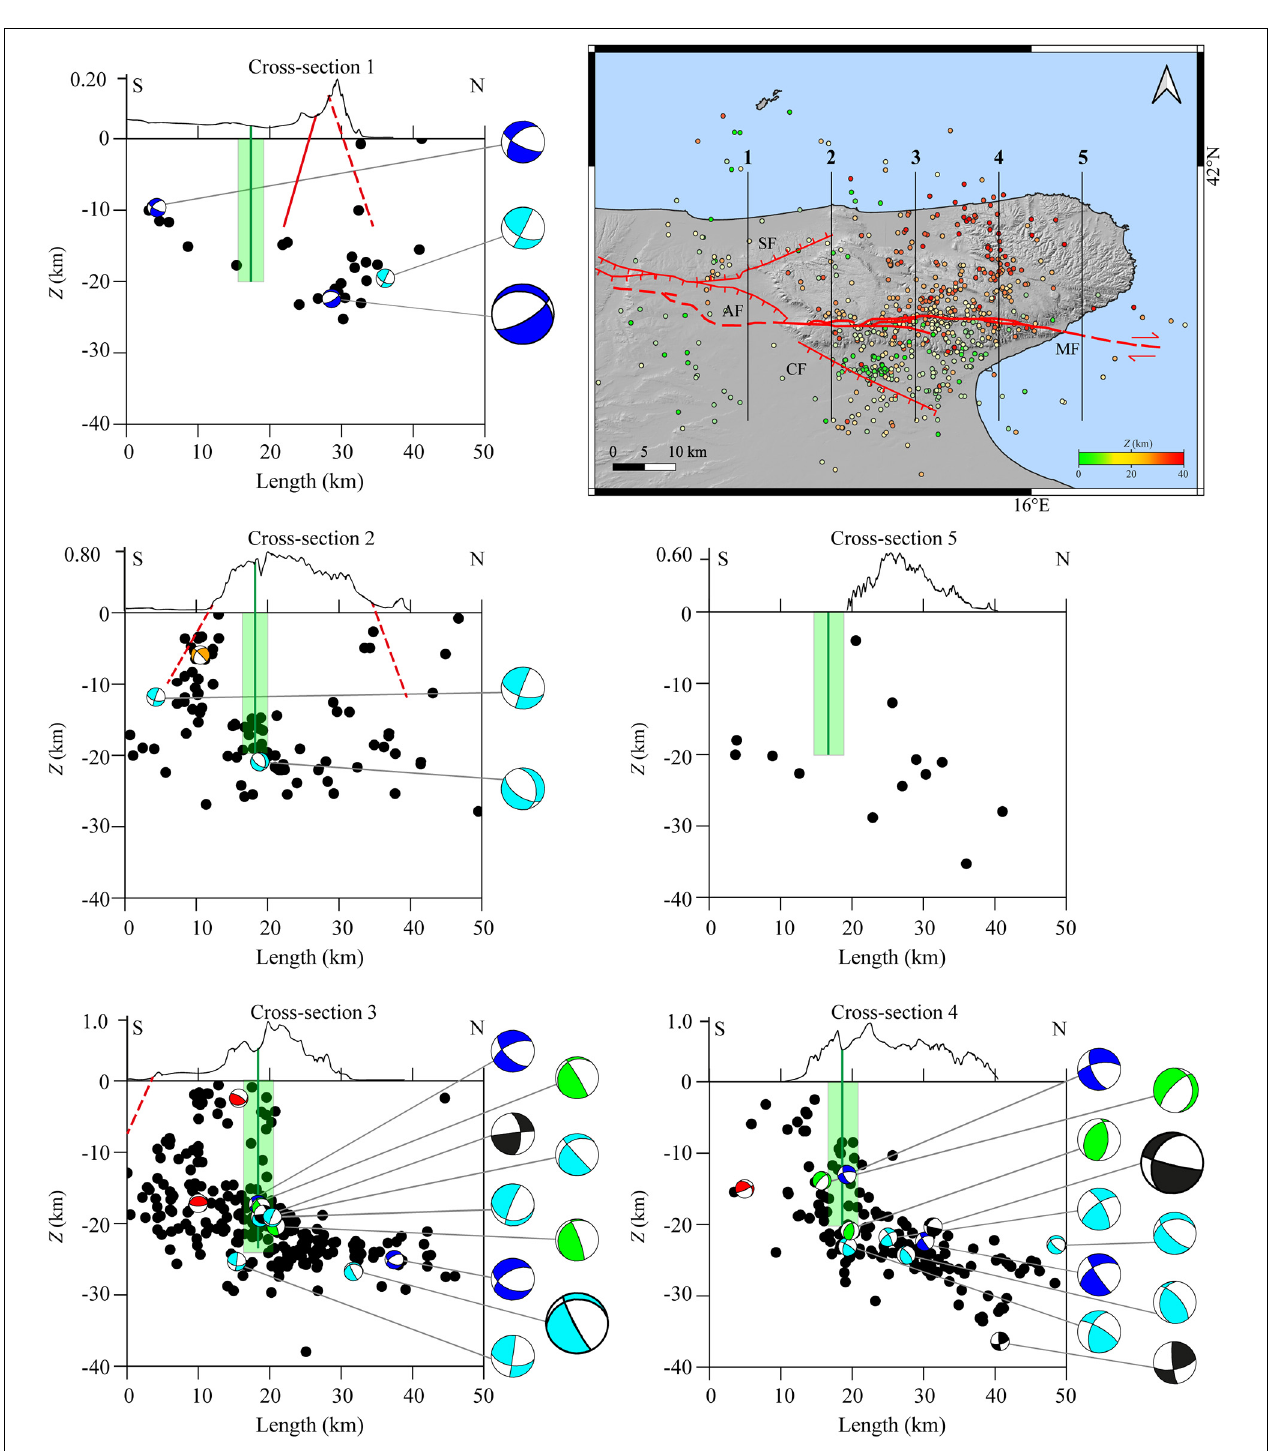
FIGURE 8 | The same as Figure 7 for the N-S cross-sections. All cross-sections have 50 km length and 8 km semi-width per side.